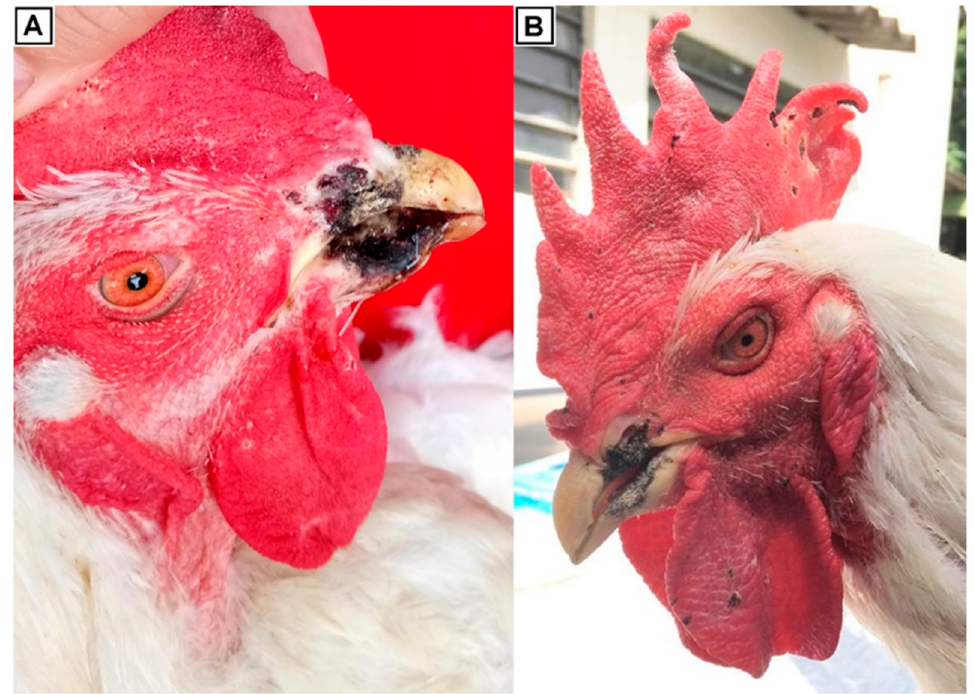
Figure 1. Gross pathology of affected roosters. ( A ) Major lesions consisted mainly of necrosis in nostrils and beaks. ( B ) Regular lesions in some birds included scabs and crusts in the combs and